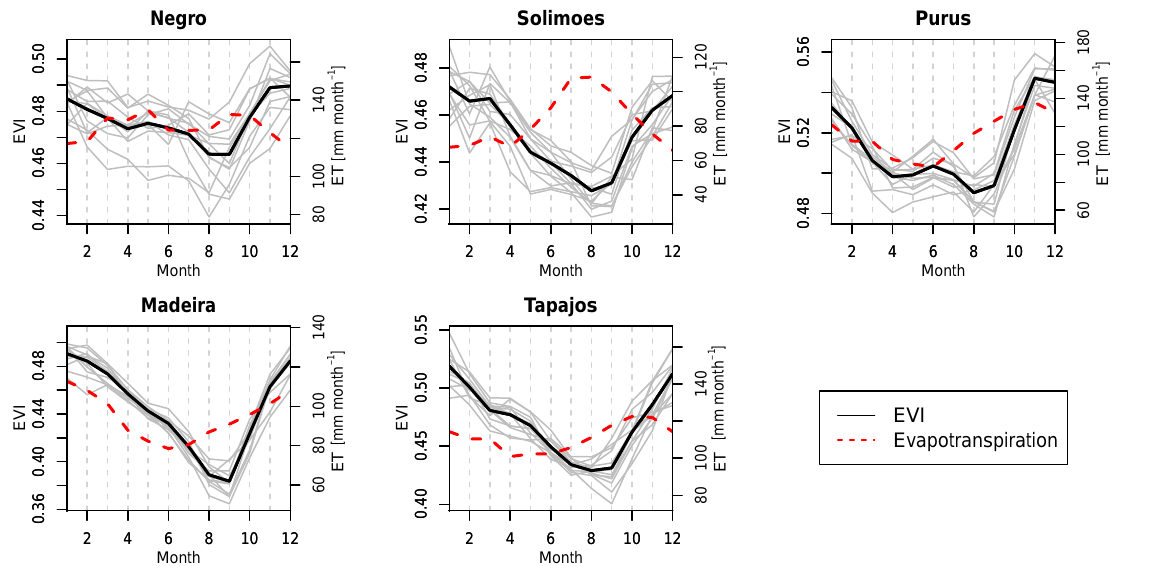
Figure 7. Seasonal patterns of MODIS EVI in the five Amazon sub-basins. The black lines show the monthly average values from 2001 to 2014, while grey lines show individual monthly values for each year. The mean seasonal variations in ET for each sub-basin are represented as red dashed